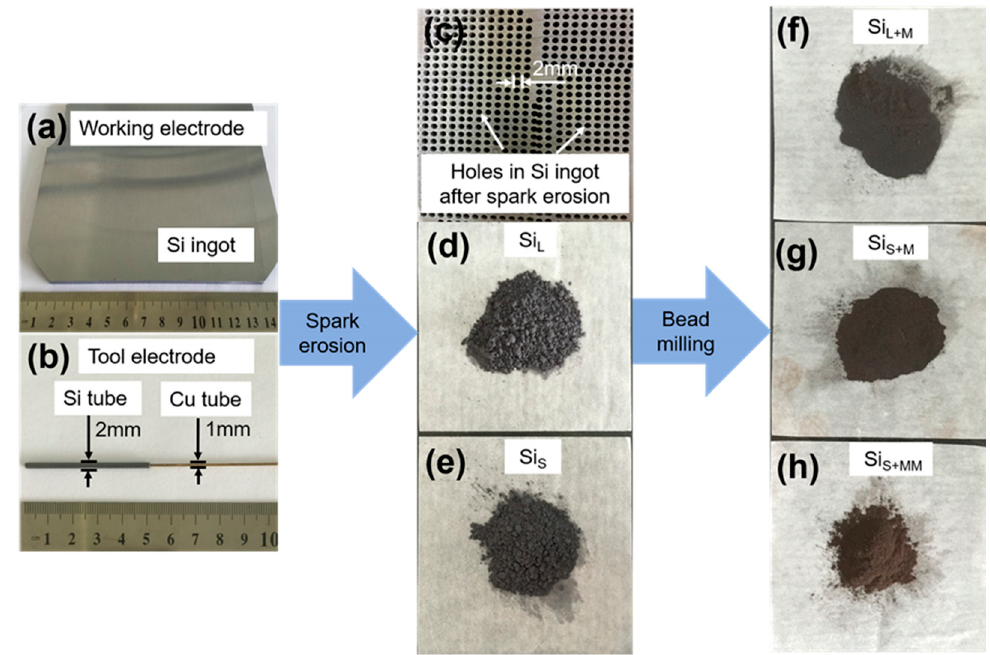
Figure 3. Pictures of ( a ) working electrode (Si ingot), ( b ) tool electrode (Si tube), ( c ) Si ingot after spark erosion, and powders of ( d ) Si L , ( e ) Si S , ( f ) Si L+M , ( g ) Si S+MM and ( h ) Si S+MM .